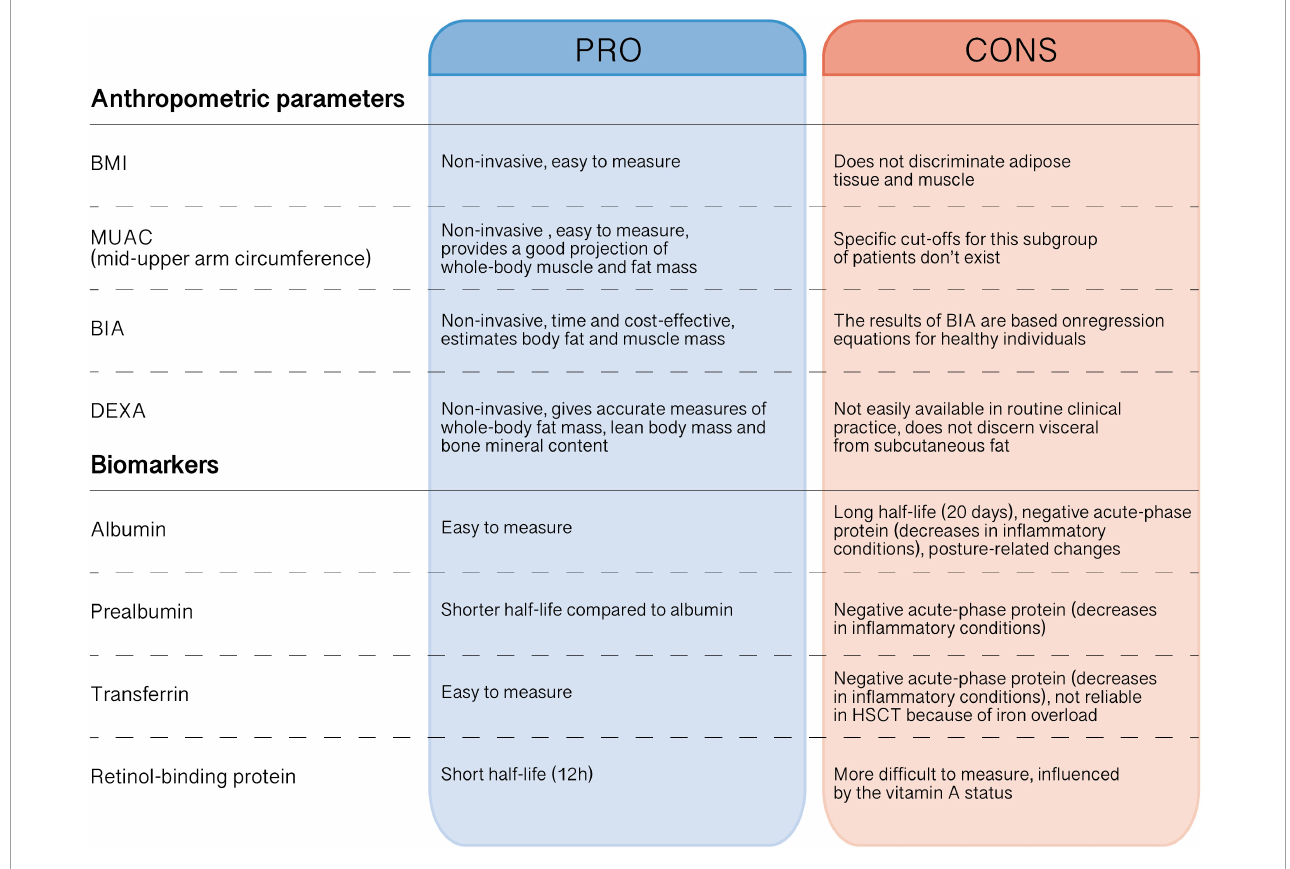
FIGURE1 Advantages and disadvantages of anthropometric and biochemical parameter used to assess the nutritional status in pediatric HSCT